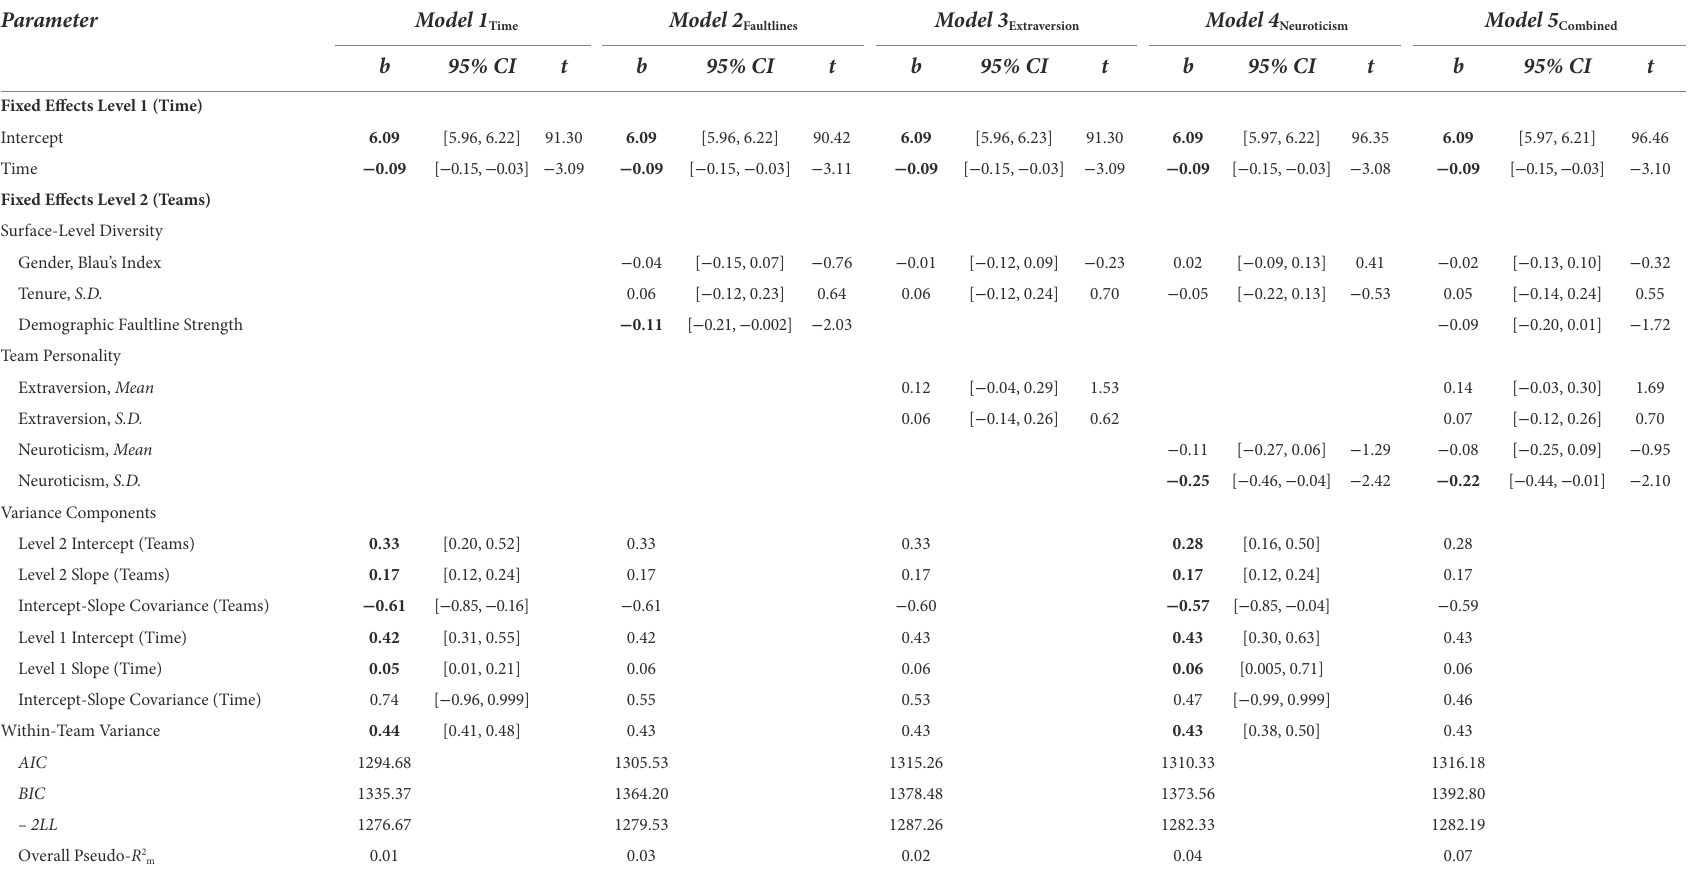
TABLE 2 Linear growth curve model ( n = 699 Measurements Nested in Three Time Points, in 233 Members in 61 Teams) for initial levels of team psychological safety.